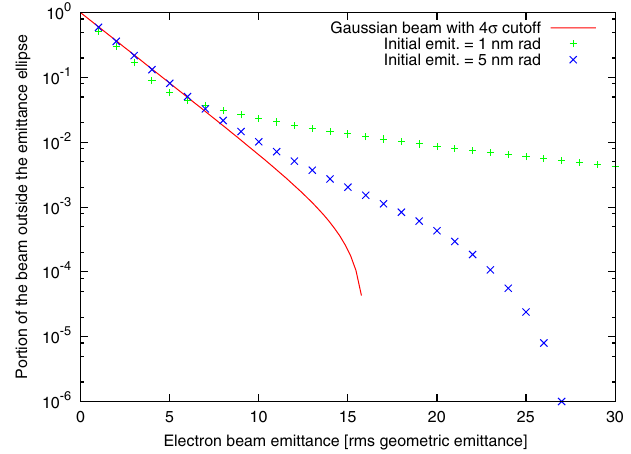
FIG. 7. (Color) The portion of electron beam after collision that is not covered by a given emittance ellipse as a function of the electron beam geometric acceptance (measured by the rms geometric emittance after the